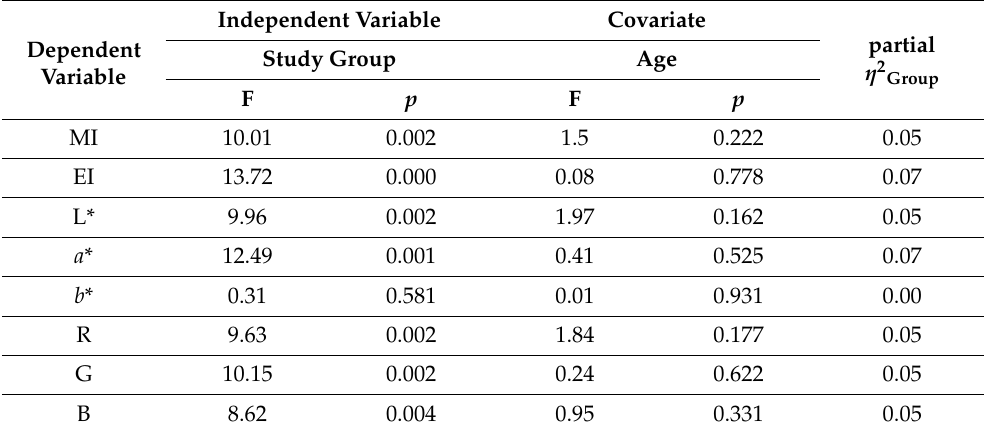
Table 3. ANCOVA results showing differentiation of the spectrophotometric skin color parameters depending on the study group in women (adjusted for age).